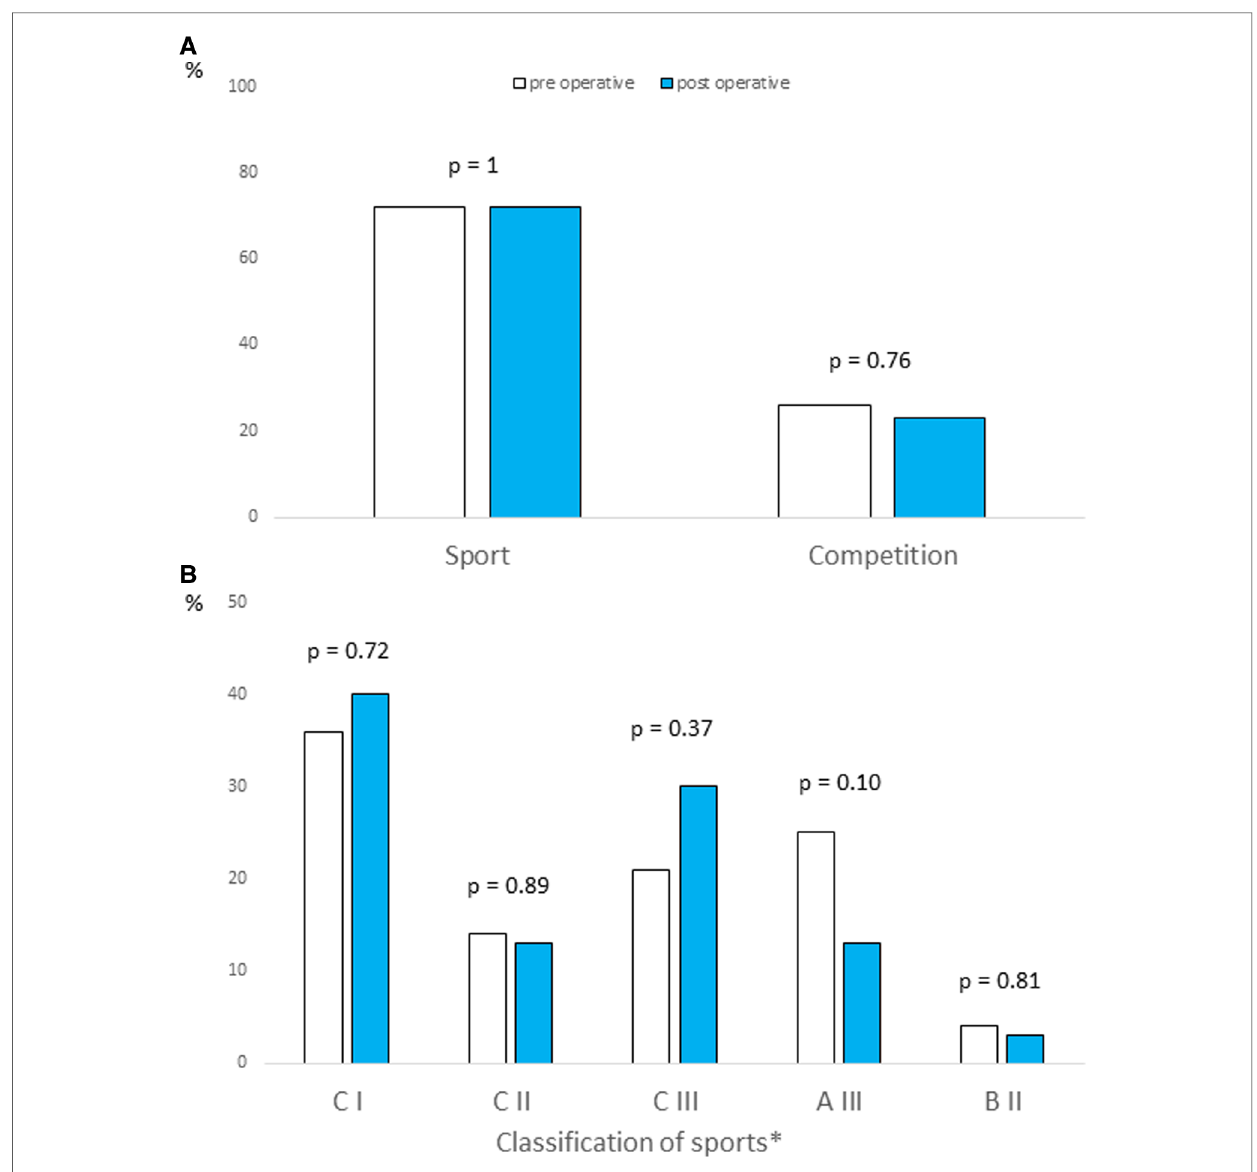
FIGURE 3 Resumption (panel A) and intensity (panel B) of sport in post operative period. *According to the AHA Guidelines